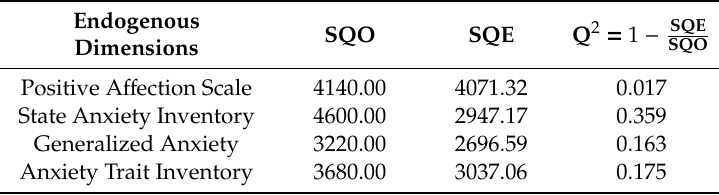
Table 14. Q 2 values for the PANAS-GAD-7-IDATE model.